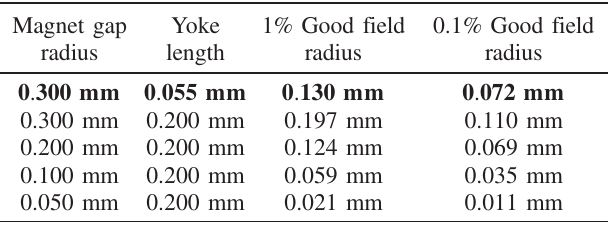
TABLE II. Good field region radius from MEMS quadrupole simulation data. The prototype quadrupole is typeset bold. Magnet gap